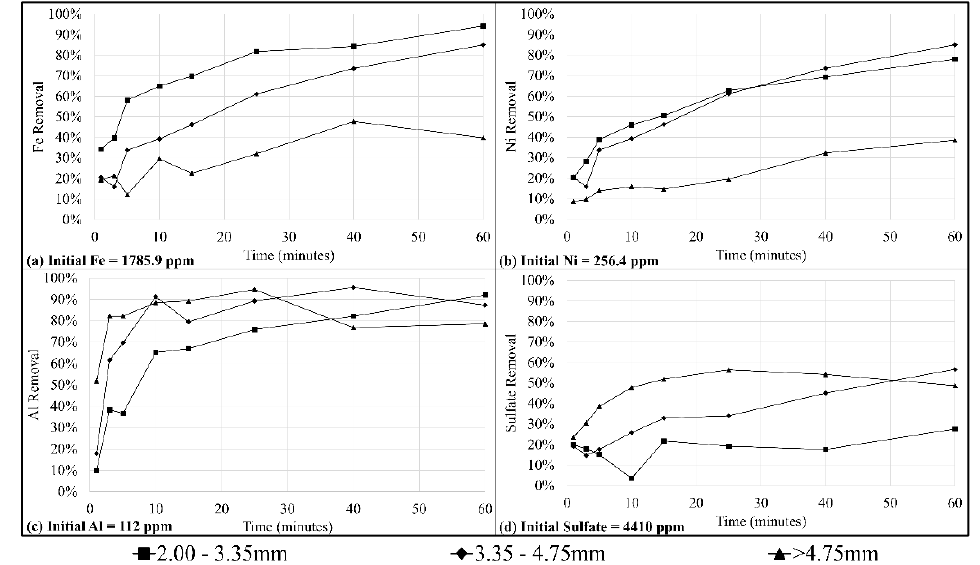
Figure 9 . Effect of particle size on the removal of ( a ) iron; ( b ) nickel; ( c ) aluminum; and ( d ) sulfates.